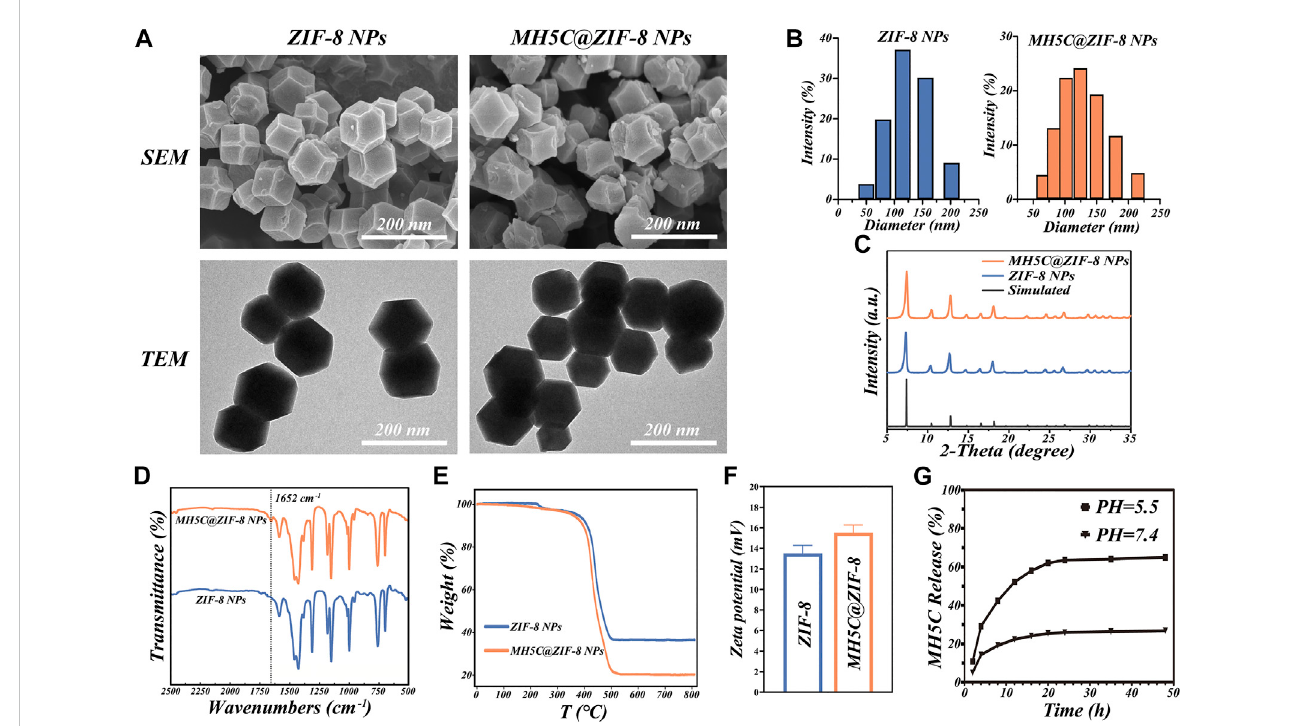
FIGURE 2 BasicpropertiesofMH5C@ZIF-8NPs. (A) SEMandTEMimagesofMH5C@ZIF-8NPsandZIF-8NPs. (B) ParticlesizedistributionofMH5C@ZIF-8NPsand ZIF-8 NPs dispersed in water. (C) XRD patterns of MH5C@ZIF-8 NPs, ZIF-8 NPs and simulated ZIF-8. (D) FTIR spectra of MH5C@ZIF-8 NPs and ZIF-8 NPs. (E) TGA curves of MH5C@ZIF-8 NPs and ZIF-8 NPs. (F) Zeta potential of ZIF-8 NPs and MLT@ZIF-8 NPs. (G) MH5C release pro fi les from MH5C@ZIF-8 in PBS solution (pH = 5.5 and